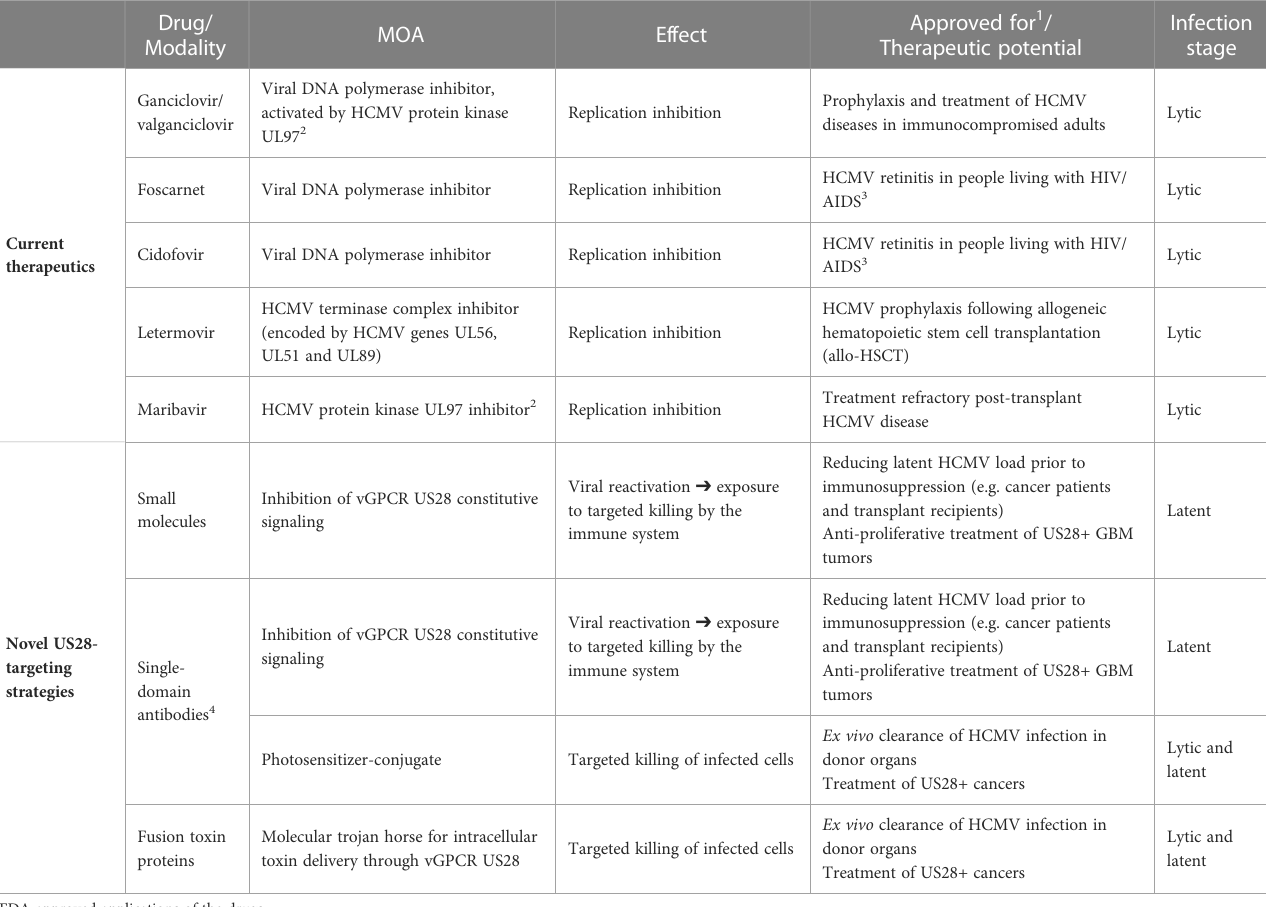
TABLE 1 Overview of current standard-of-care drugs and the novel US28-targeting strategies under development, including modes of action (MOA), treatment effects and therapeutic